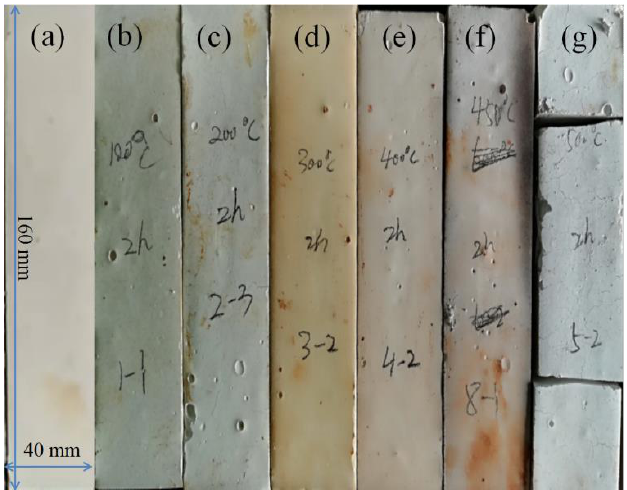
Figure 1. Macromorphology of MOC ( a ) cured for 28 days at room temperature and then heated at ( b ) 100 °C, ( c ) 200 °C, ( d ) 300 °C, ( e ) 400 °C, ( f ) 450 °C, and ( g ) 500 °C.